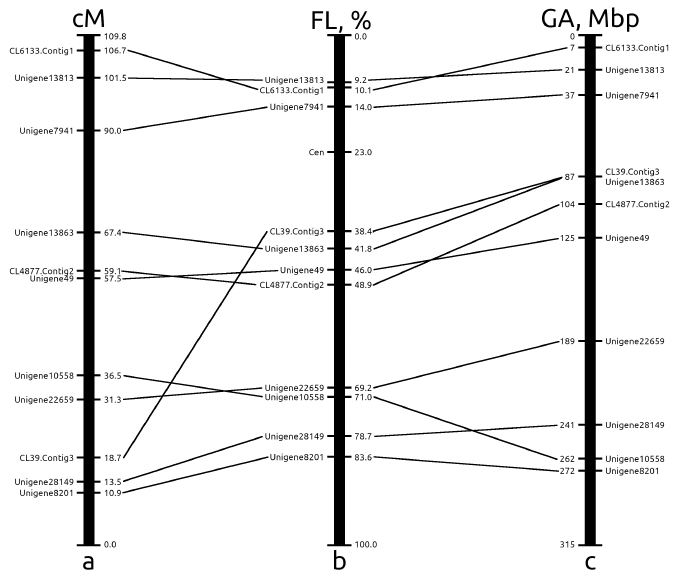
Figure 6. Alignment of the genetic, chromosomal and pseudochromosome maps of onion chromo- some 6: ( a ) the position of Tyr-FISH markers on genetic map of the linkage group 6 described by Fujito et al. [29]; distances in centiMorgans are shown on the right of linkage group; ( b ) the positions of Tyr-FISH mapped markers on physical chromosome are expressed as percentage of the fractional length (FL - distance from the telomere end of the short arm to the signals divided by the length of the entire chromosome); ( c ) the positions of Tyr-FISH markers on pseudochromosome 6 described by Finkers et al. [25] are expressed as the position of a gene sequence possessing of Tyr-FISH marker within one Mbp bin of pseudochromosome 6 (a total size of pseudochromosome 6–315